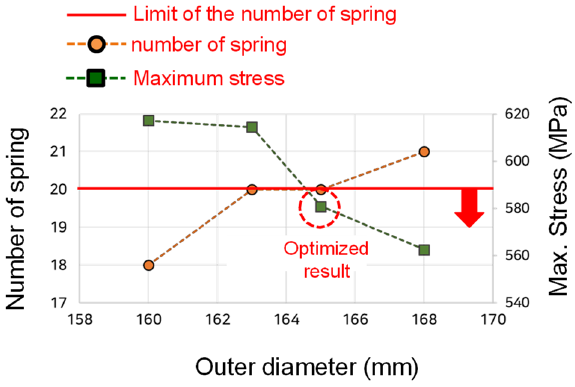
Figure 17. Simulation for the optimized results at spring thickness of 1.5 mm.